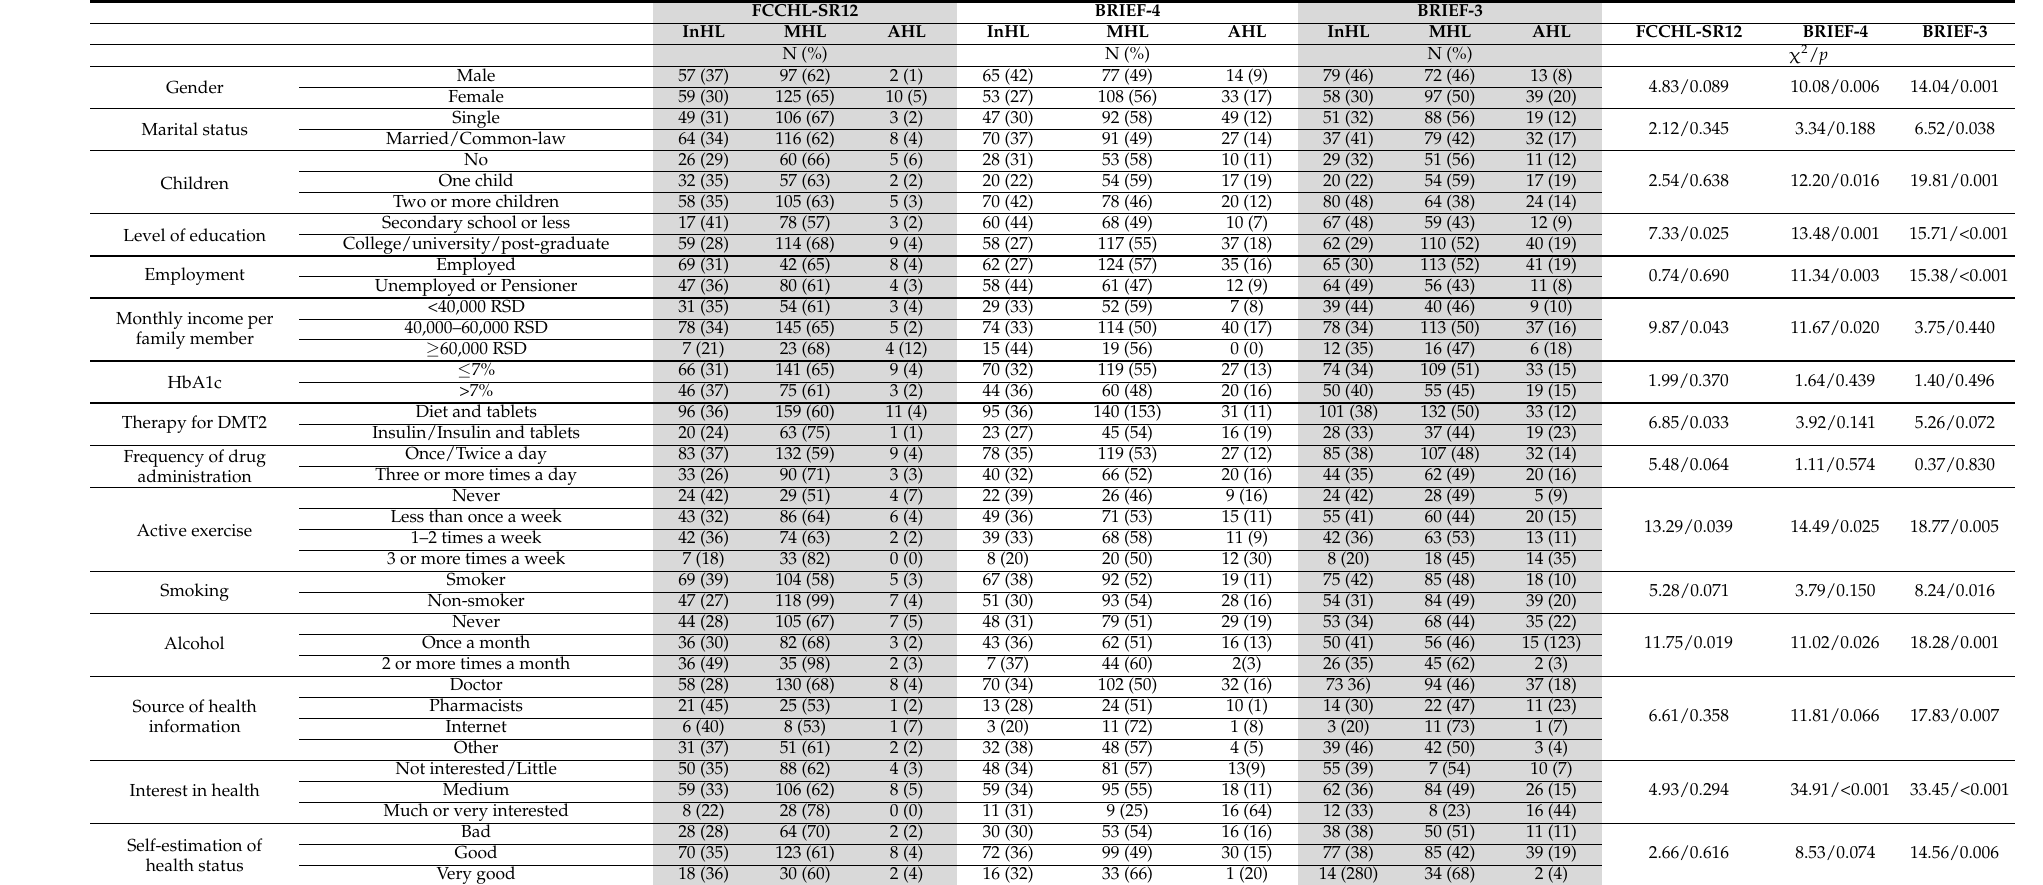
Table 3. Observed variables associated with HL level by FCCHL-SR12, BRIEF-4, and